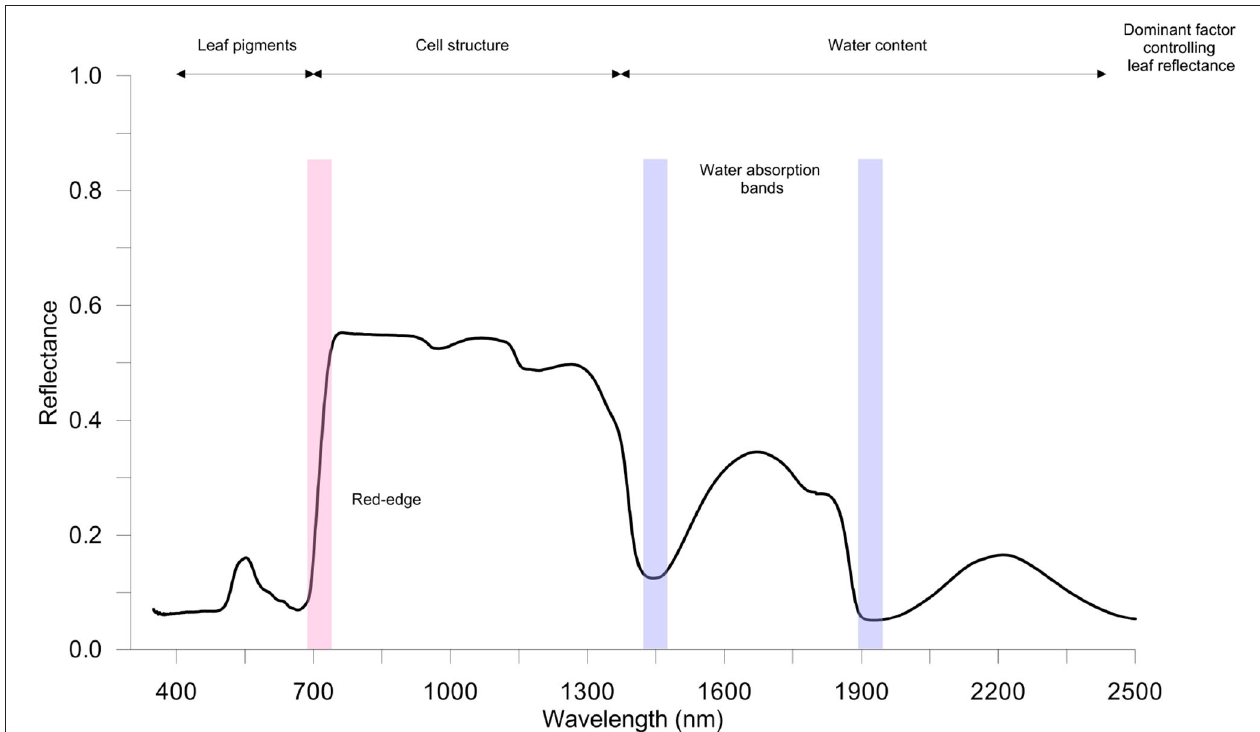
FIGURE 2 | A typical healthy vegetation spectrum (350–2,500 nm); spectral reflectance signature refers to spinach leaves (author’s personal and unpublished data). Measurements were taken using full-range hyperspectral ASD FieldSpec 4 Hi-Res (Analytical Spectral Devices Inc., Boulder, CO, USA) spectroradiometer equipped with a contact probe. Red-edge and water bands’ absorption sections are highlighted in red and blue,